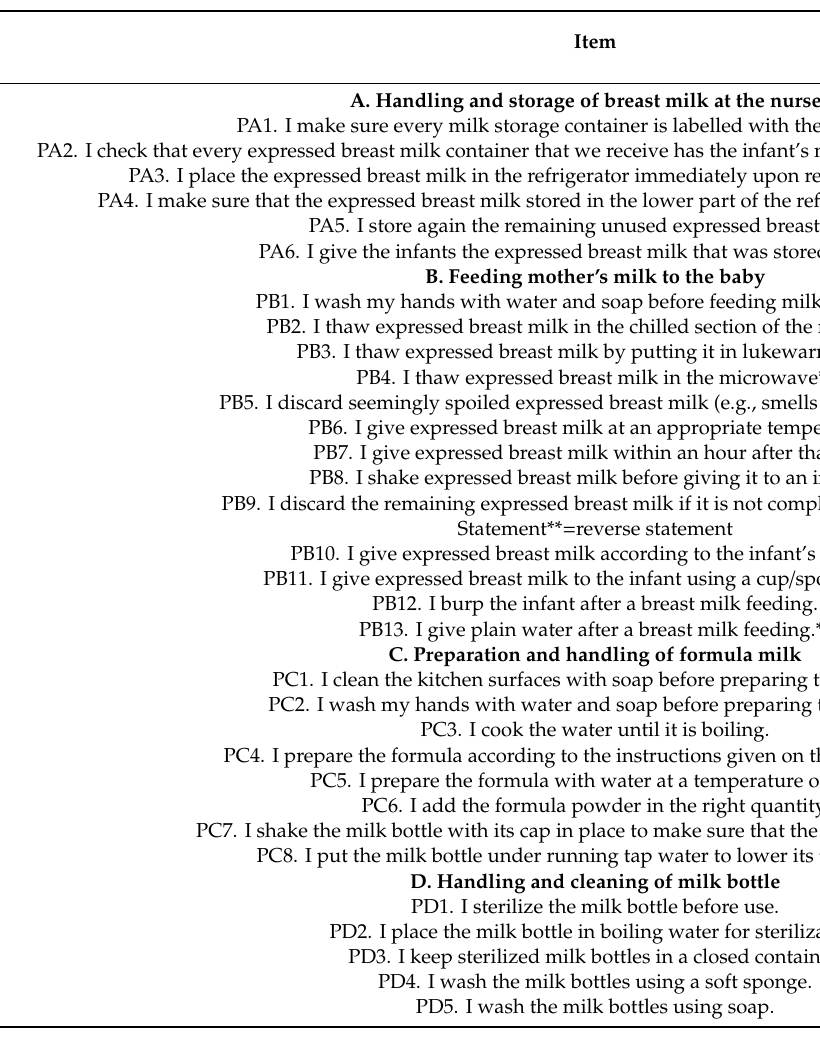
Table 7. Descriptive statistics of the items for practices regarding breastfeeding and complementary feeding ( n = 200). Item A. Handling and storage of breast milk at the